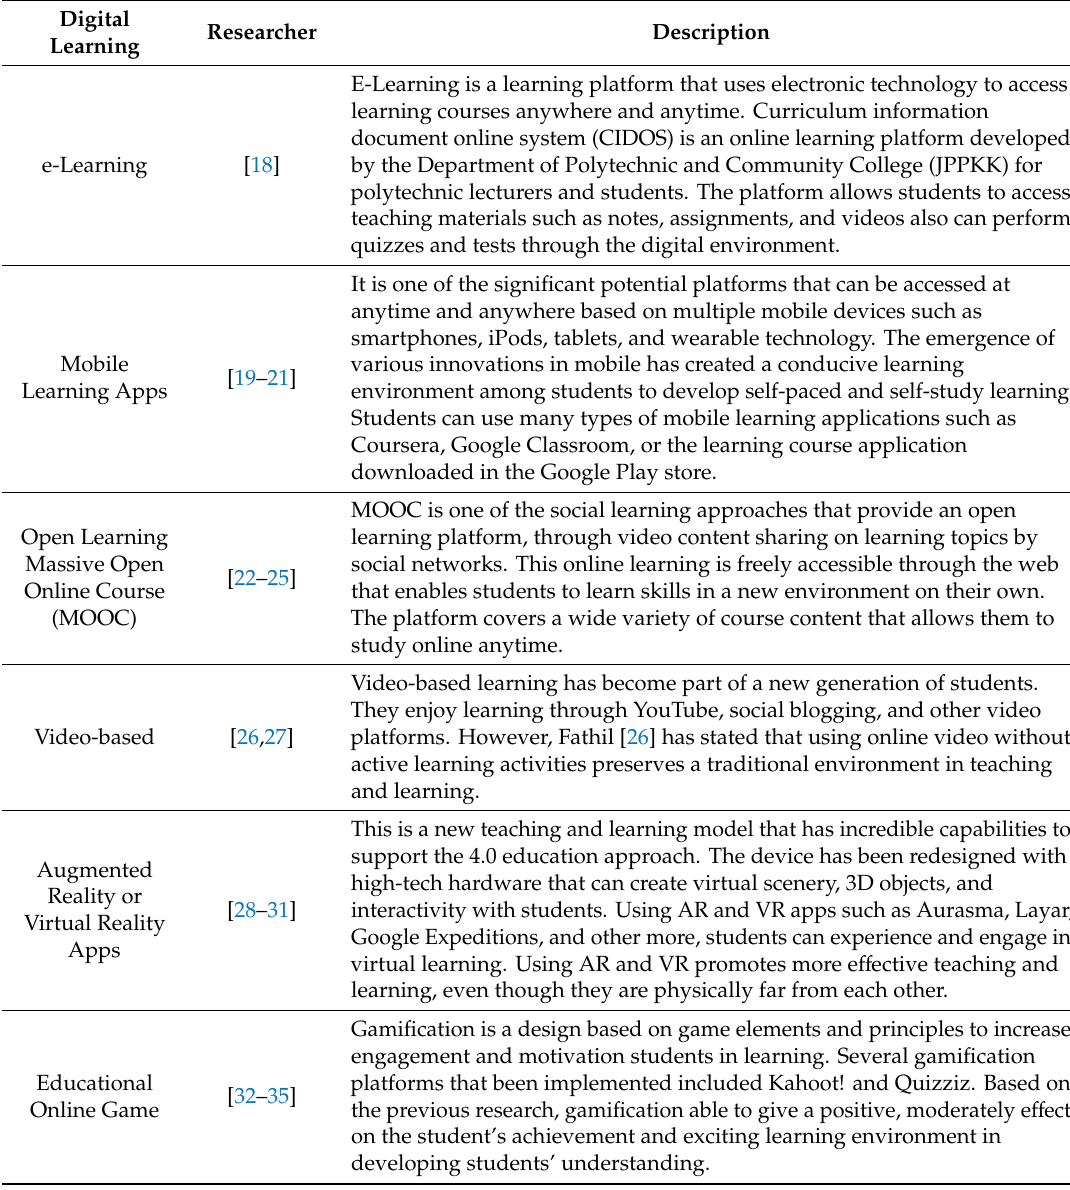
Table 2. Related studies of digital learning platforms and